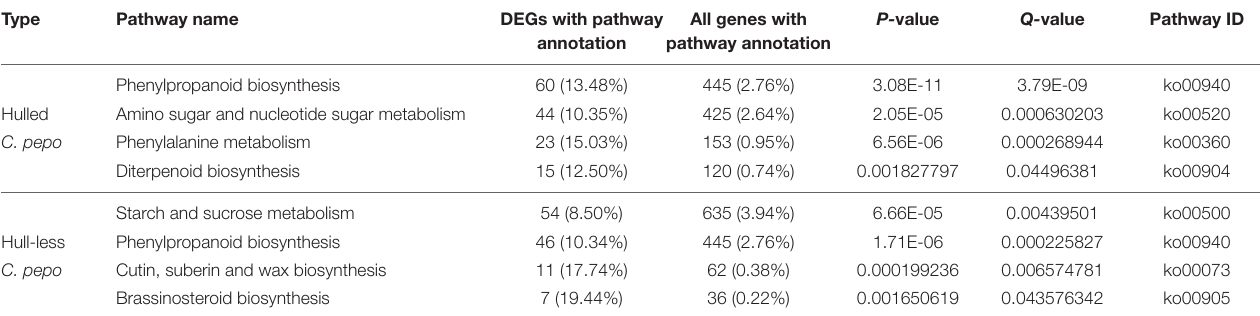
TABLE 1 | Significant KEGG pathways enrichment analysis of DEGs.